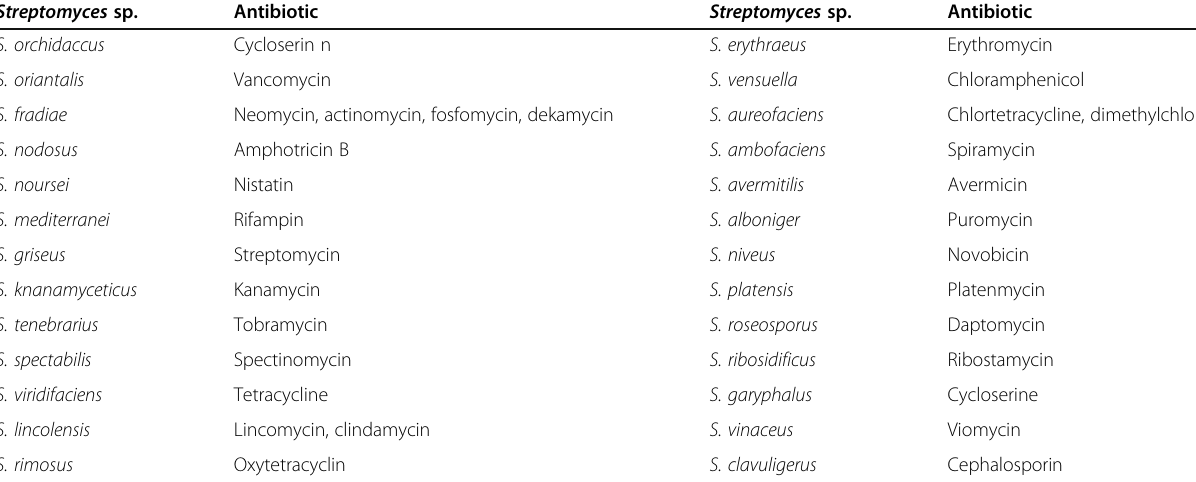
Table 3 List of some antibiotics produced by Streptomyces sp . [47] Streptomyces